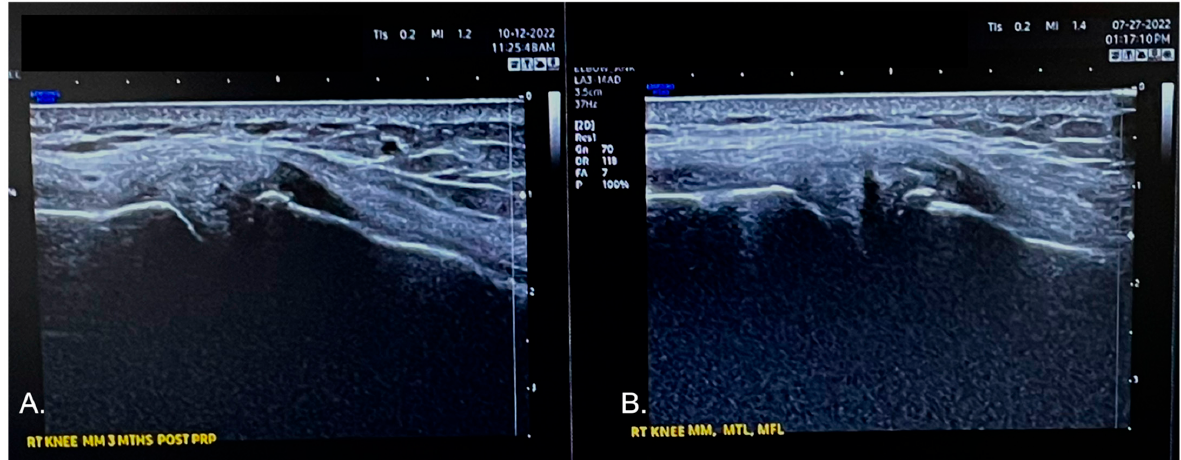
Figure 5. A comparative image of the right knee showing medial meniscus and MCL. In situation ( A ), 11 weeks after the procedure, the medial meniscus is visible following an intra-meniscal NR-PRP injection. In situation ( B ), the pre-treatment condition of the meniscus is visualized.